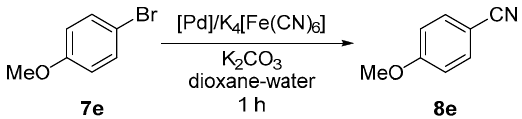
Scheme 4. The model cyanation reaction used during the screening experiments.